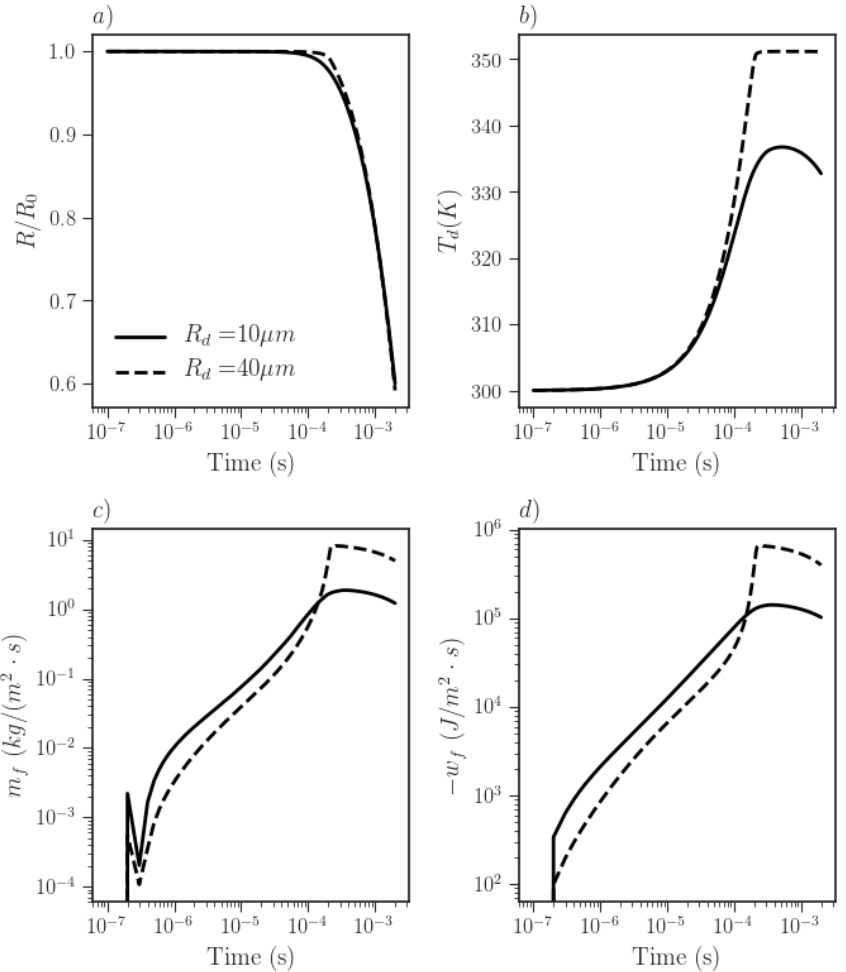
Figure 8. Temporal evolution of ethanol droplet heating and evaporation during continuous heating; ( a ) normalized radius, ( b ) droplet temperature, ( c ) evaporation mass flux, and ( d ) conduction and convective heat flux. Solid lines represent droplet of size R D = 10 µ m, and dashed lines represent droplet of size R D = 40 µ m; I L 0 = 10 10 W/m 2 .